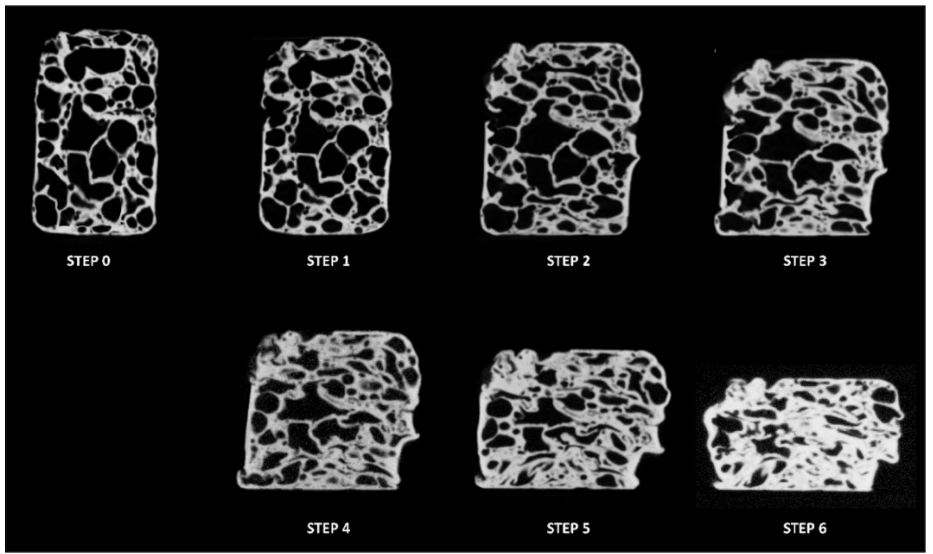
Figure 7. Processed CT images of section XZ recorded at the end of the compression steps (0.4% TiH 2